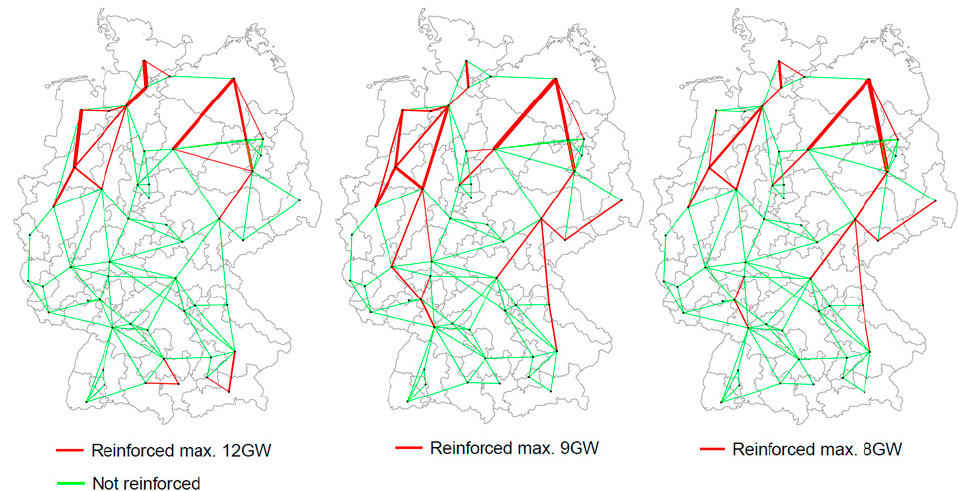
Figure 6. Overlaying grid expansion in 2050 in the scenario “Stagnation and scepticism—central” for the variants A’ ( left ), A ( middle ), and B ( right ). Green lines indicate no grid reinforcement; red indicates that the grid was